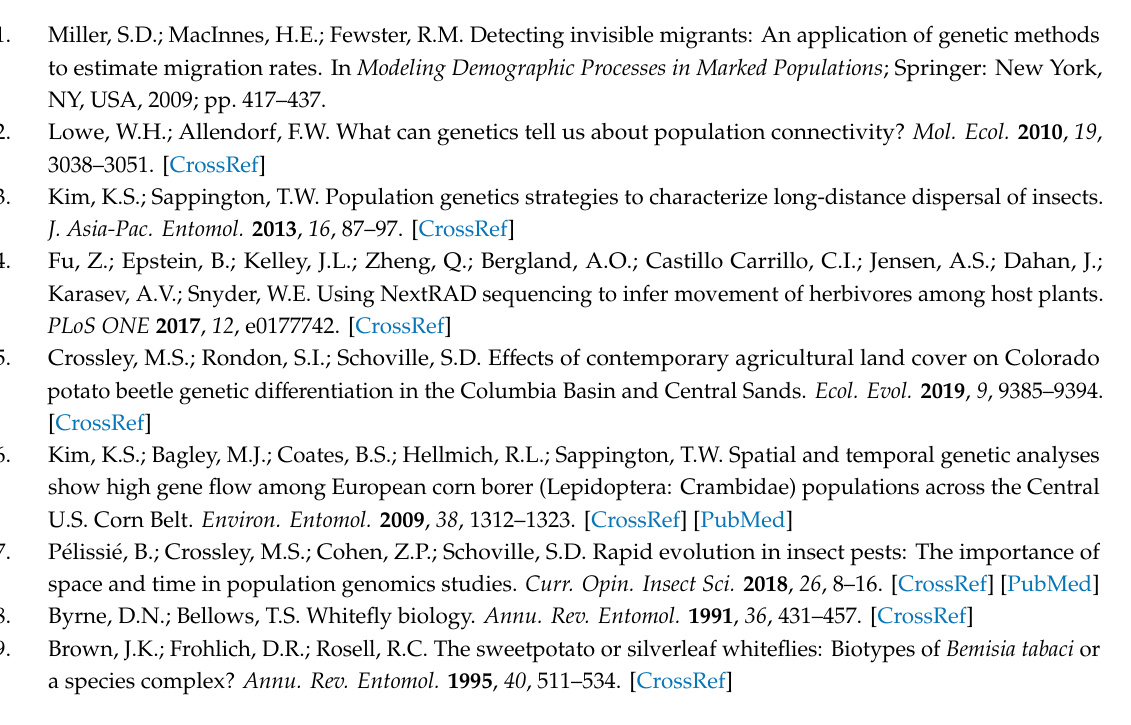
Table S1: Summary of select attributes of reviewed research articles, Table S2: Summary of genetic diversity and di ff erentiation among cryptic species and